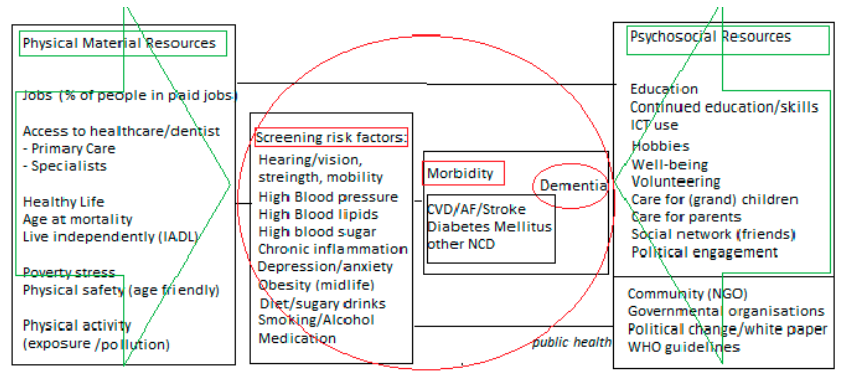
Figure 2. The Compression of Needs Model (Hogervorst, first discussed ADI, 2020 Singapore).